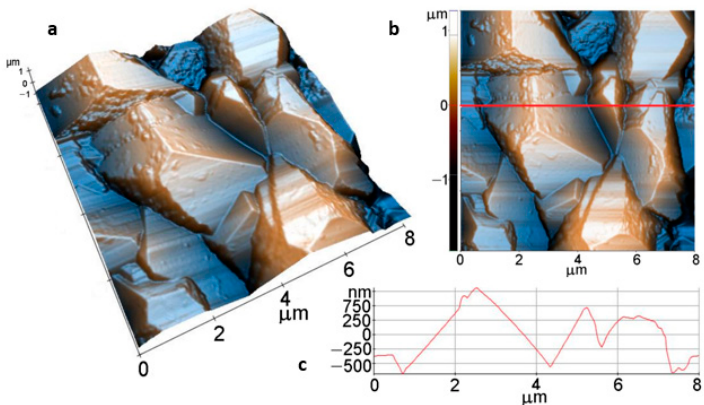
Figure 10. Tri-dimensional ( a ) and bi-dimensional ( b ) AFM images and line profile ( c ) of Mg surface after 1h immersion. Further on, for an immersion time of 1 day, the AFM images in Figure 11, also scanned over an area of (8 µm × 8 µm), show much larger faceted crystals, with dimen- sions of a few microns (see Figure 11a,b). The coating preserves the compact morphology, but a finer surface texture is suggested by the aspect of some exposed crystal facets. However, at the (8 µm × 8 µm) scale, the roughness parameters are similar to the values obtained from the sample immersed for 1 h in Figure 10, as follows: Rq = 478.1 nm, and Rpv = 3.21 µm (Figure 11c).